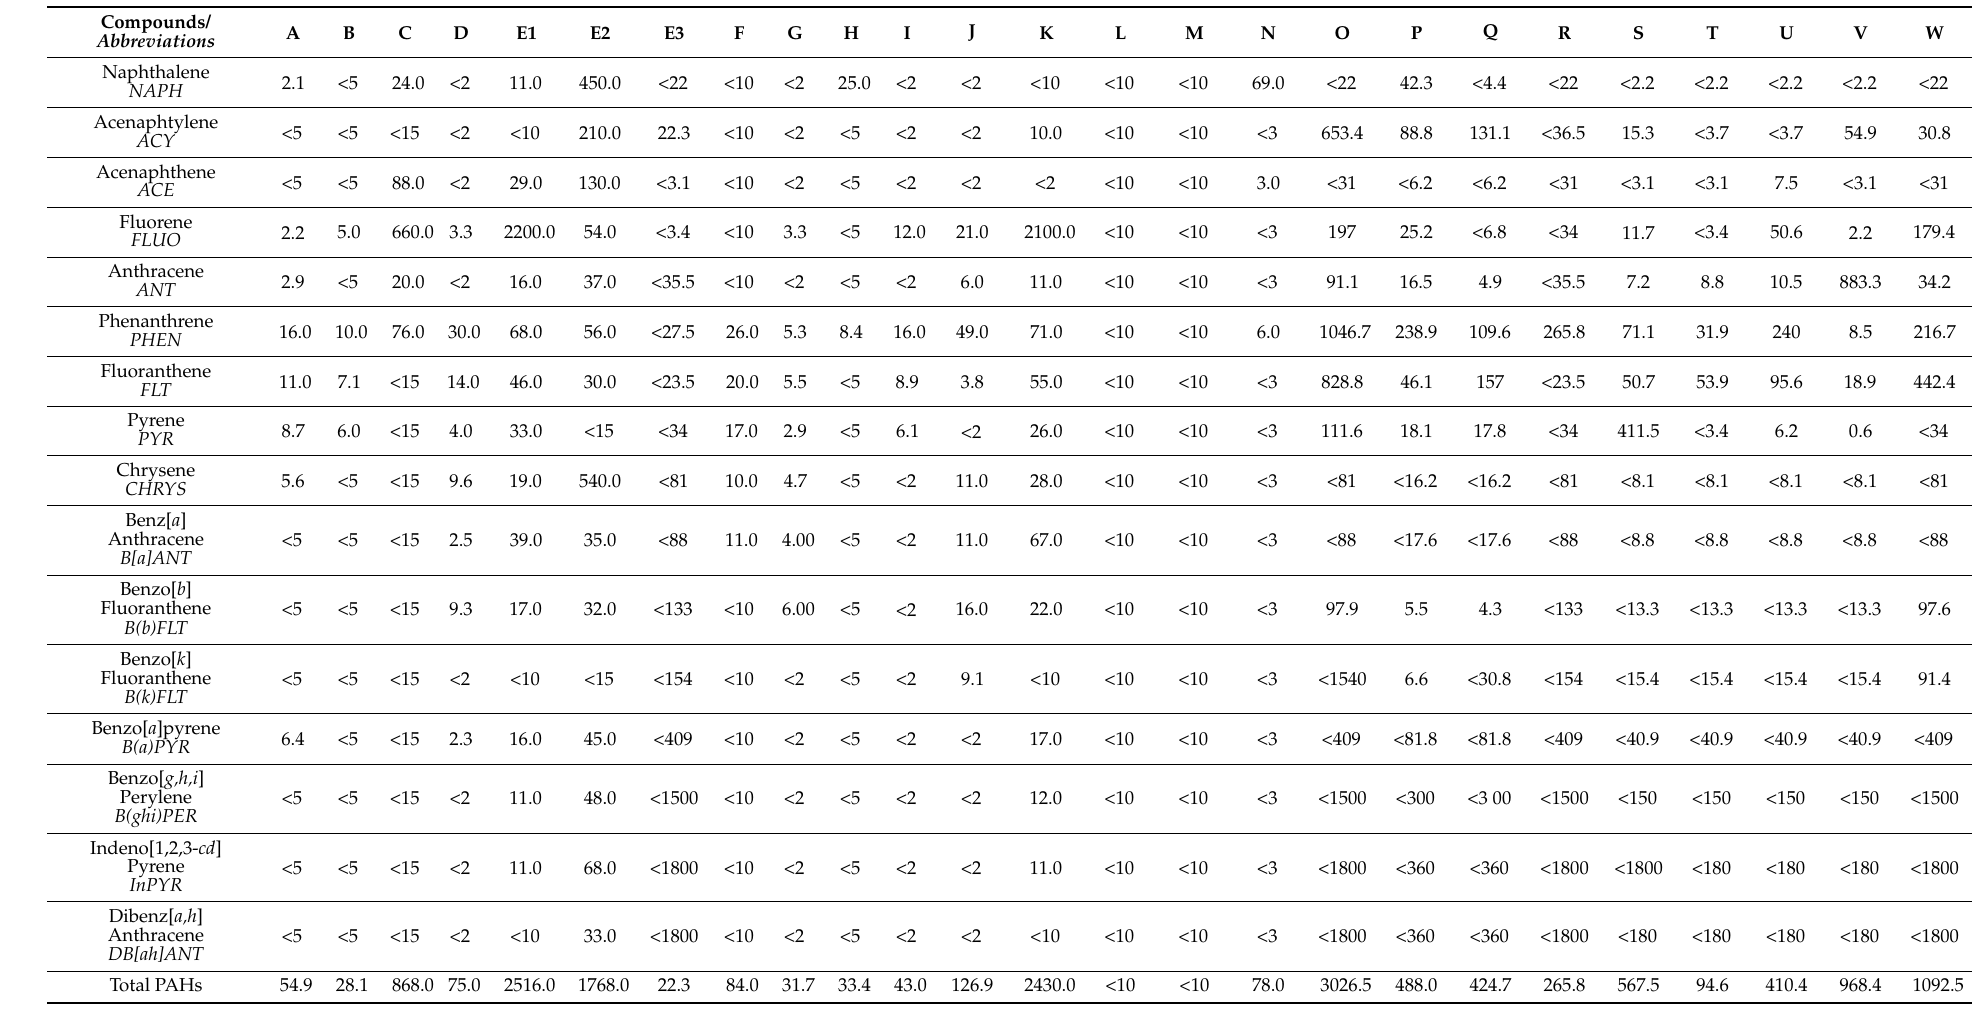
Table 4. PAHs amounts for each pesticide A-W in µ g/L. E1 to E3 were the same pesticide, but from different lots; they were used as internal controls in our blinded measurements. All values < mean <